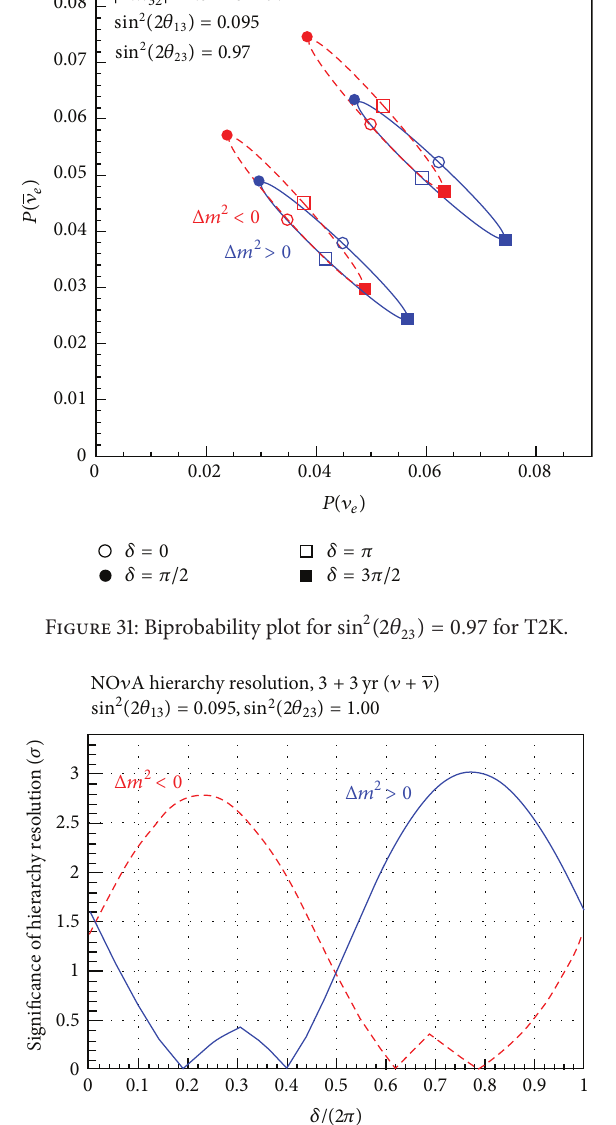
Figure 32: Significance of the resolution of the mass ordering as a function of 𝛿 in standard deviations. These sensitivities are for NO 𝜈 A alone for the two possible orderings and sin 2 (2𝜃 23 ) = 1.0. The zeros correspond to the crossing of the ovals in Figure